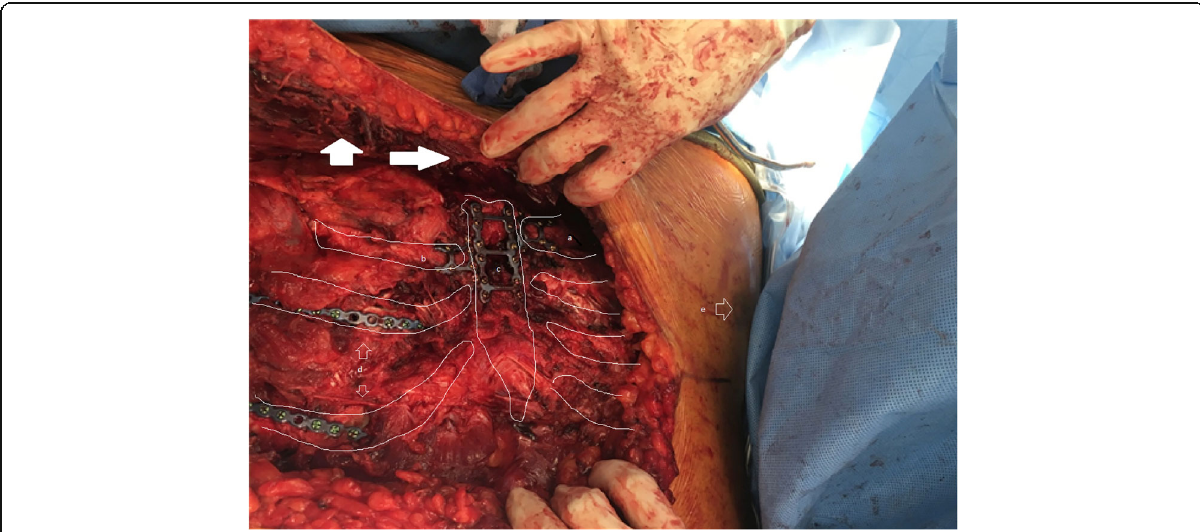
Fig. 4 Operative view of the reconstruction, showing: (a) repair of the sternochondral dislocation of the left side, (b) repair of the sternochondral dislocation on the right side, (c) Sternal repair, (d) the flail chest repair with ribs stabilization, (e) left nipple. The solid white arrows points to the myocutaneous pectoral flap already elevated